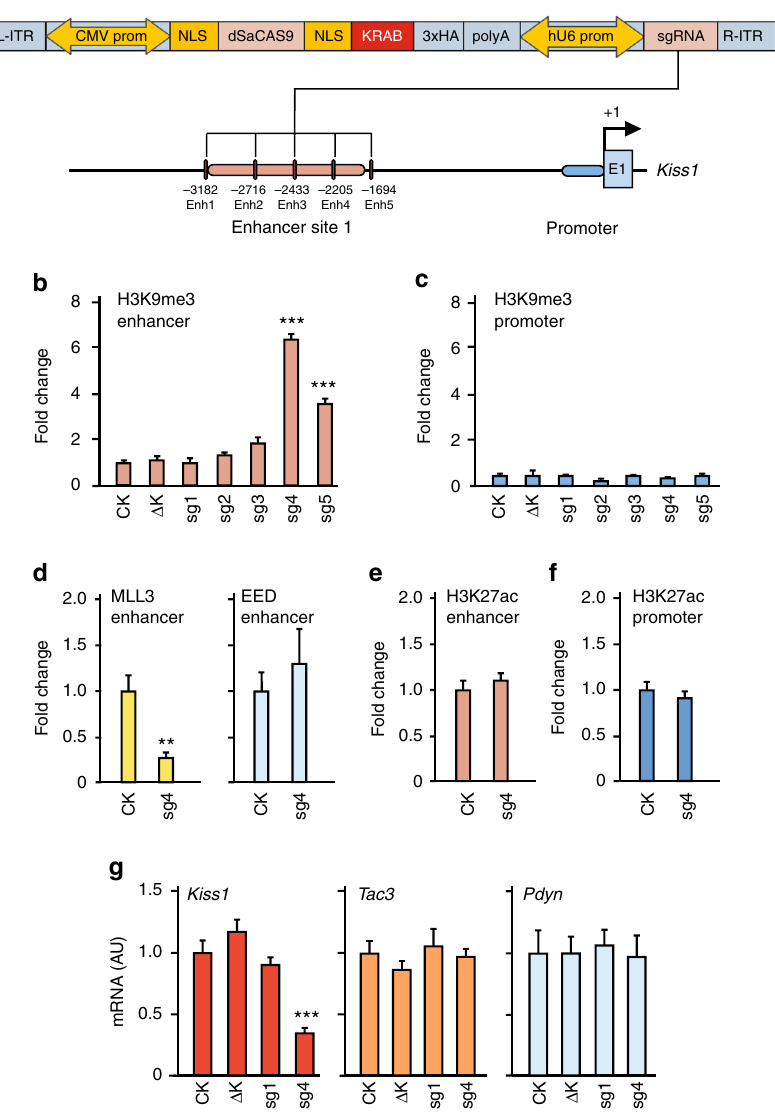
Fig. 7 CRISPR-dSaCas9-KRAB-mediated epigenome silencing of the ARC Kiss1 enhancer. a Schematic representation of the AAV-dSaCas9-KRAB construct used for epigenome editing of the Kiss1 enhancer. The AAV plasmid backbone contains a CMV promoter driving expression of dSaCas9-KRAB, two nuclear localization signals (NLS) fl anking dSaCas9, and three copies of an in fl uenza hemagglutinin (3xHA) tag. It also contains a single-guide (sg) RNA cloning site and a U6 promoter driving sgRNA expression. sgRNAs complementary to fi ve different sequences in site 1, the putative Kiss1 enhancer domain, were identi fi ed using an online tool (https://www.deskgen.com/) and cloned into the AAV-dSaCas9-KRAB vector as recommended 66 . b H3K9me3 content at the Kiss1 enhancer (site 1) or c Kiss1 promoter as assessed by ChIP-qPCR 2 days after transfecting Rat1 cells with AAV-dSaCas9-KRAB-sgRNAs 1 – 5 (sg1 – 5)